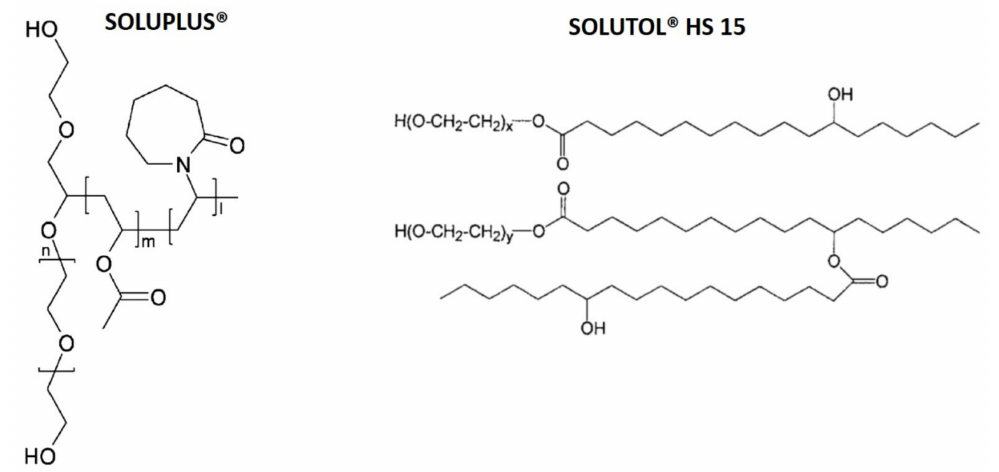
Figure 2. Chemical structures of Soluplus ® and Solutol ® HS15.